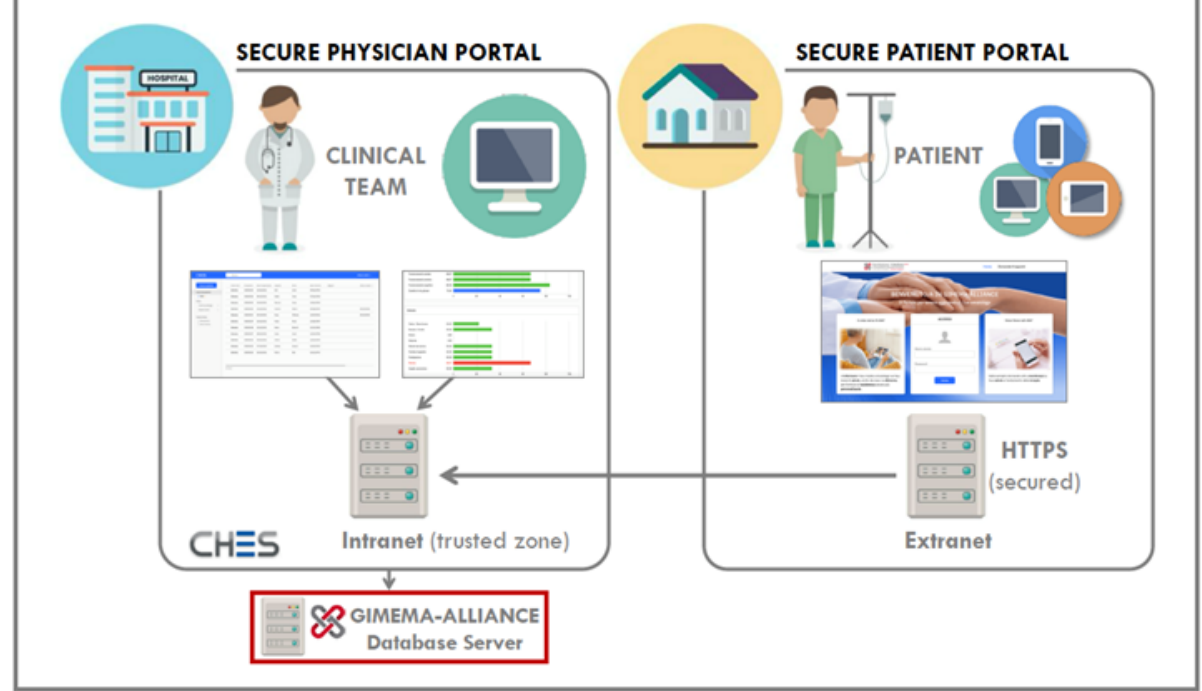
Figure 1. Main workflow of the GIMEMA-ALLIANCE platform. ALLIANCE: An online platform to improve patient-centered care during the COVID-19 pandemic: A GIMEMA surveillance program in hematologic malignancies; CHES: Computer-based Health Evaluation System; GIMEMA: Gruppo Italiano Malattie Ematologiche dell’Adulto.